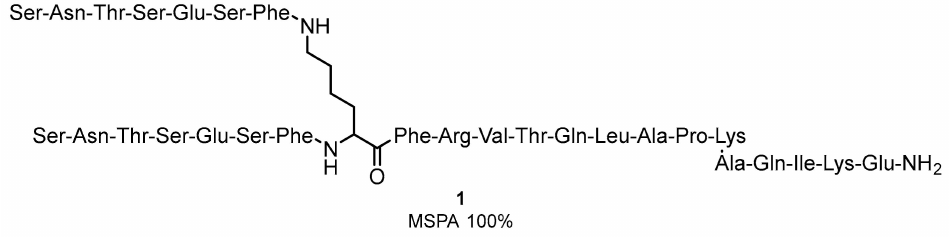
Figure 1. Structure of AUNP-12 ( 1 )—A 29-residue peptide sequence.